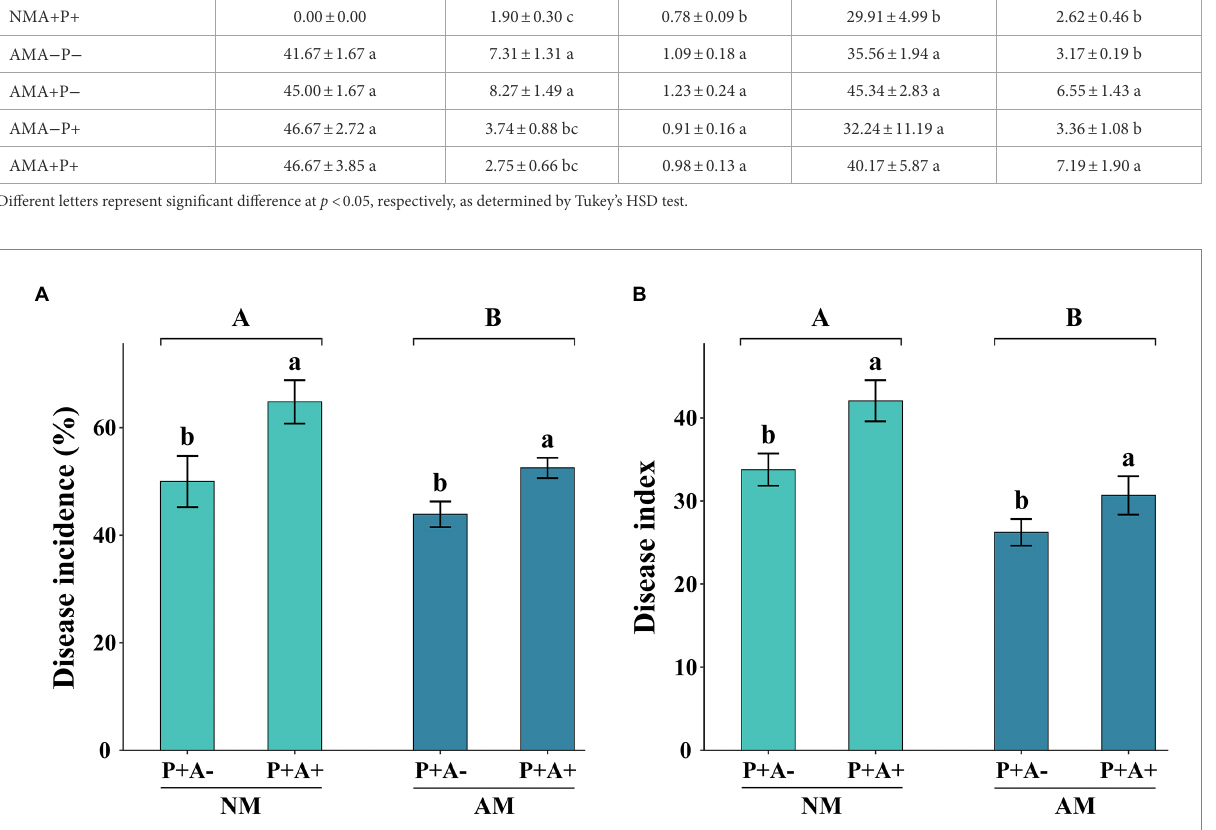
FIGURE 2 (A) Disease incidence and (B) disease index of Medicago sativa inoculated with Rhizophagus intraradices (AM) and infested with Acyrthosiphon pisum (A+) or non-inoculated with R. intraradices (NM) and non-infested with A. pisum (A − ). All values are the mean ± SEM of three biological replicates. Different letters above pairs of bars indicate a significant difference in the comparison at p < 0.05. Asterisks indicate a significant difference between P + A+ and P + A − as determined by Tukey’s HSD test. SEM, standard error of the